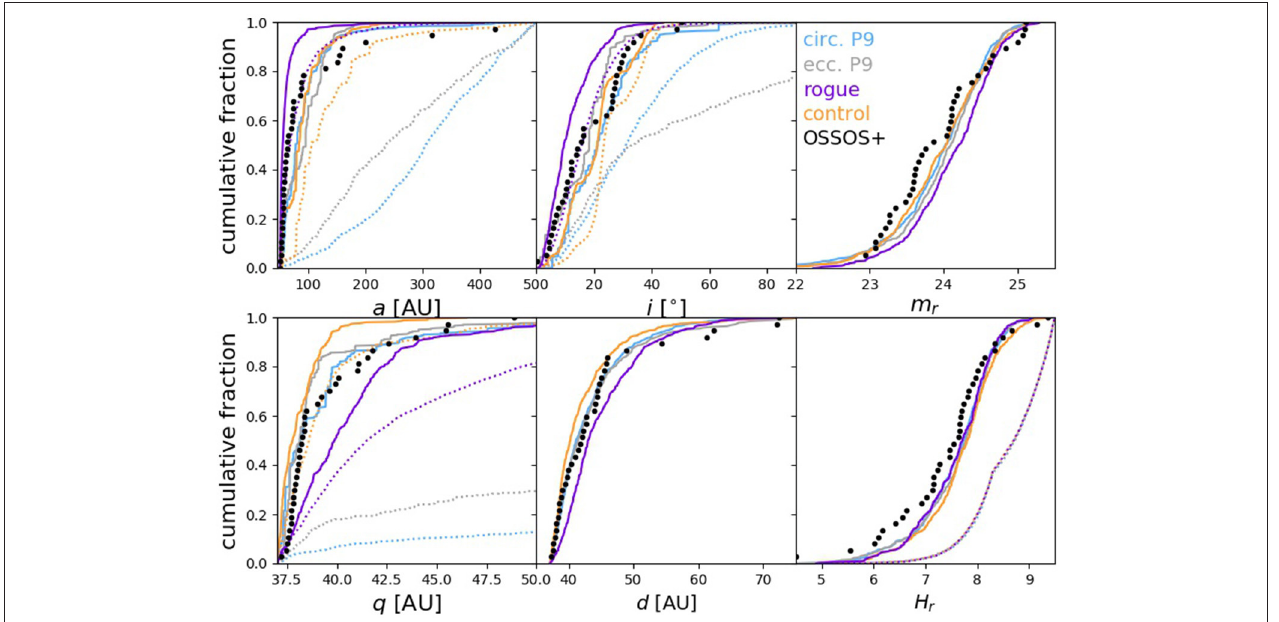
FIGURE 1 | Cumulative distributions of TNOs in six different parameters: semimajor axis a , inclination i , apparent r -band magnitude m r , pericenter distance q , distance at detection d , and absolute magnitude in r -band H r . The result of four different emplacement models are presented: the known Solar System (orange), the Solar System plus a circular orbit Planet 9 (blue), or plus an eccentric orbit Planet 9 (gray), and a “rogue” planet simulation (purple). The intrinsic model distributions are shown with dotted lines, and the resulting simulated detections in solid lines. Black circles show non-resonant TNOs discovered by the OSSOS ensemble having q > 37 AU and 50 < a < 500